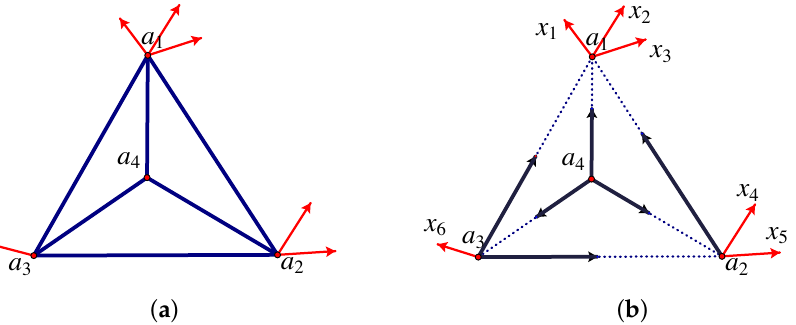
Figure 28. A tied down tetrahedron ( a ) with 6 tie-downs red arrows) has a single 3-directed orienta- tion of the edges and the tie-down ( b